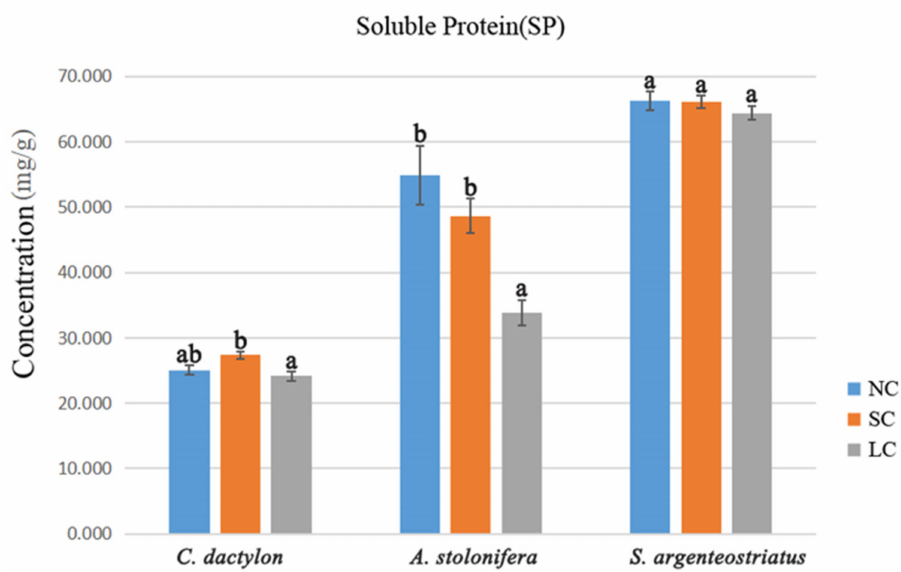
Figure 9. Graph of soluble protein concentrations. Note: Different normal letters indicate significant differences among treatments ( p < 0.05).